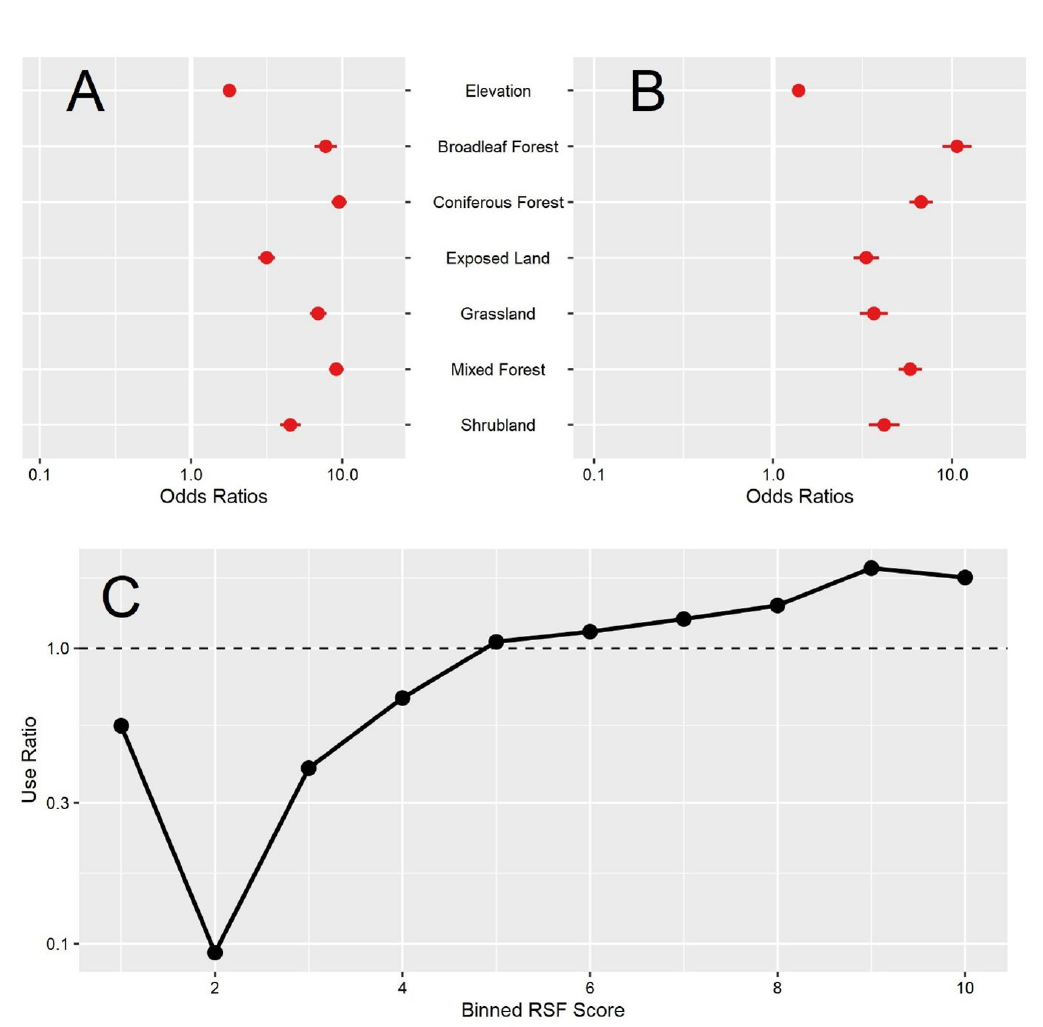
Figure 2. Model results for resident (A) and translocated (B) Southern Mountain caribou in the Columbia North range of southeastern British Columbia. Panel C shows frequency of use by resident caribou of equal-area bins developed from fitted translocated RSF values. Spearman’s rank correlation shows strong performance when us- ing habitat selection patterns of translocated animals to predict those of resident caribou (rho = 0.95, P <